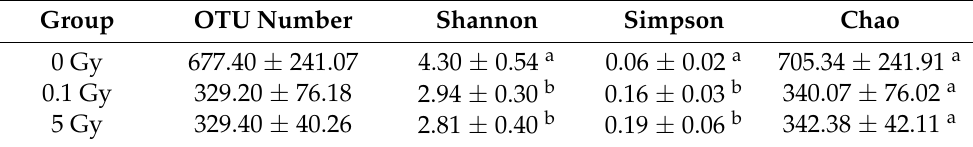
Table 1. Summary for microbial diversity analysis by 454